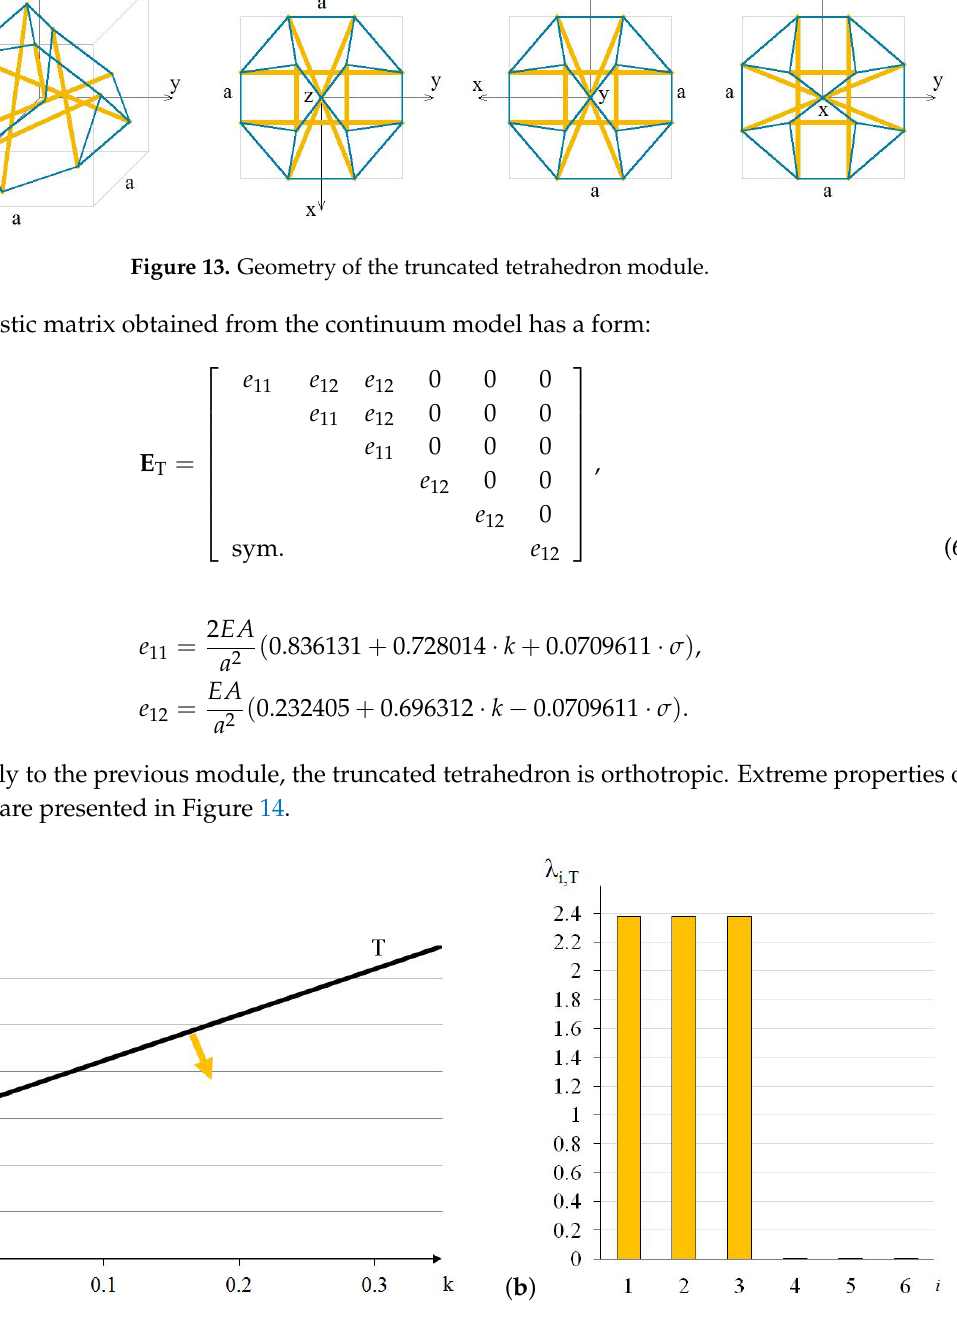
Figure 14. Extremepropertiesofthetruncatedtetrahedron: ( a )Lineofextremeproperties σ = 3.275 + 9.81 · k . ( b ) Distribution of eigenvalues for k = 0.1, σ = 4.256 (multiplier EA / a 2